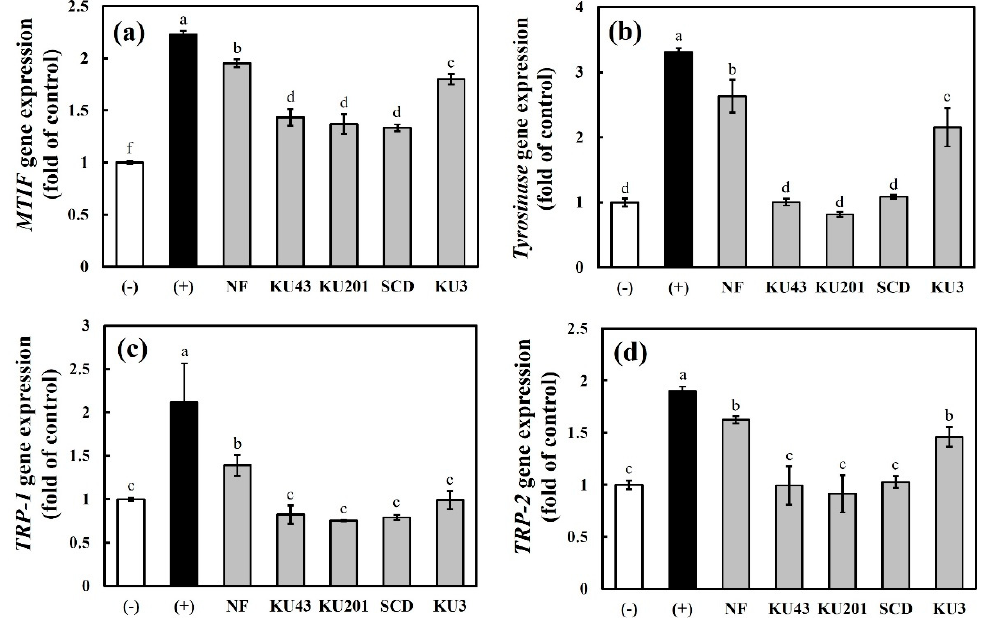
Figure 7. Relative gene expression levels of melanogenesis mediators in B16F10 cells: ( a ) microphthalmia- associated transcription factor (MITF) ; ( b ) tyrosinase ; ( c ) tyrosinase-related protein (TRP)-1 ; ( d ) TRP-2 . ( − ): negative control without α -melanocyte-stimulating hormone ( α -MSH); (+): positive control with α -MSH; NF: nonfermented hydroponic ginseng (HG); KU43: HG fermented with B. subtilis KU43; KU201: HG fermented with B. subtilis KU201; SCD: HG fermented with B. polyfermenticus SCD; KU3: HG fermented with B. polyfermenticus KU3. The data are represented as means ± standard deviations of triplicates. Statistical differences ( p < 0.05) are represented with different letters above error